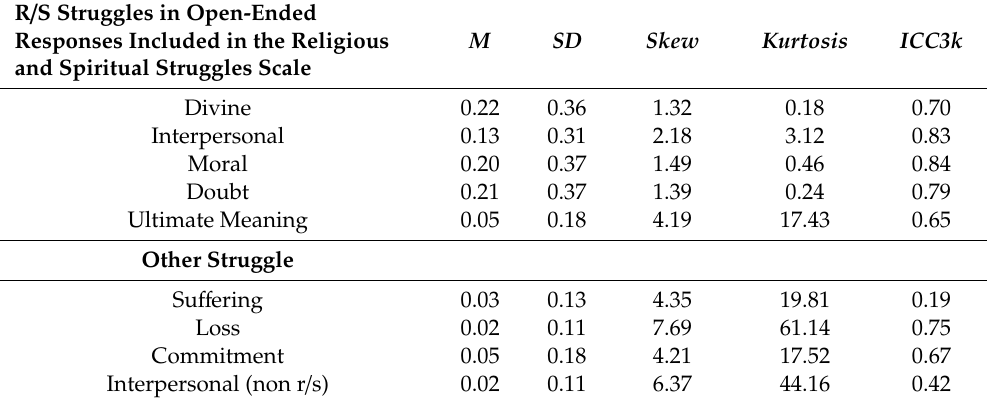
Table 2. Types of Religious / Spiritual Struggles Emerging from Open-Ended Responses: Descriptive Statistics and Reliabilities.